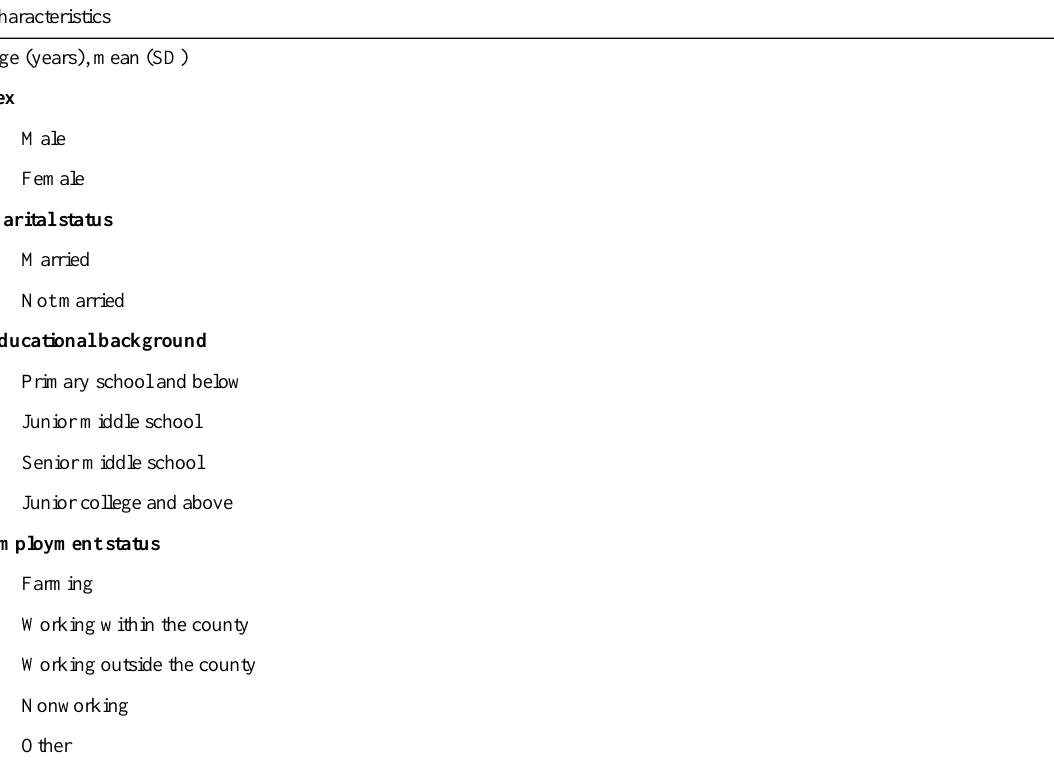
Table 1. Characteristics of the rural participants (N=543).